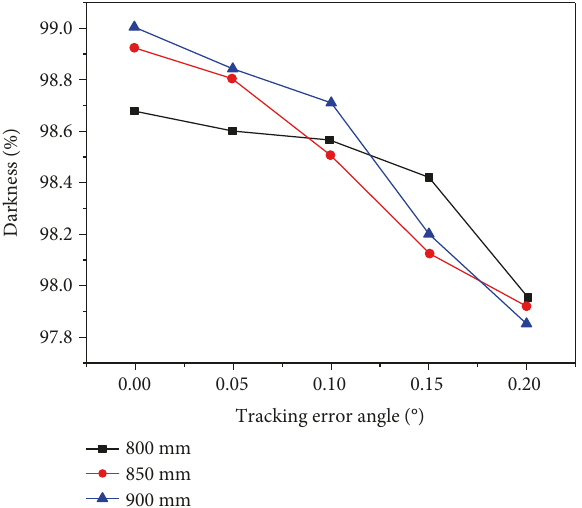
Figure 8: Darkness of the newly proposed cavity receiver under di ff erent tracking error angles and PTC focal distances.